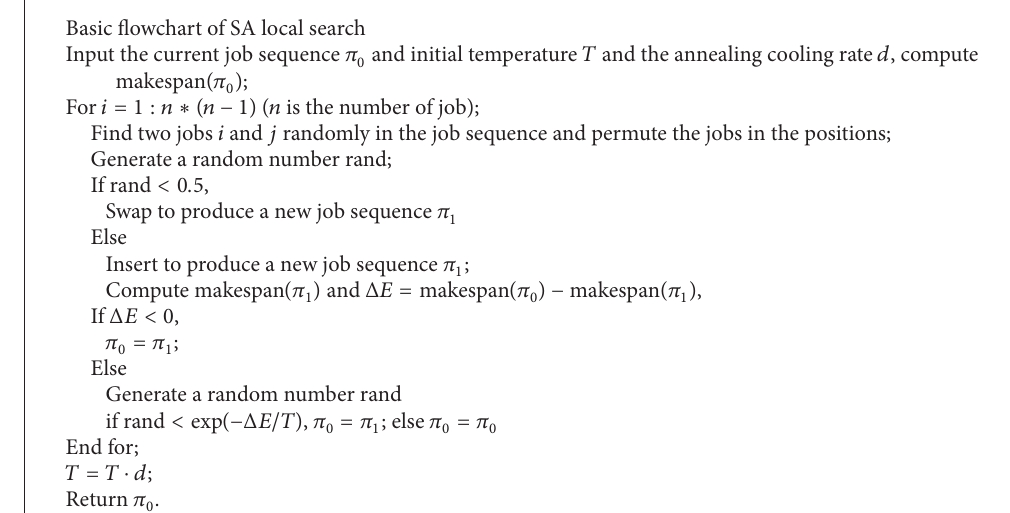
Algorithm 5: The basic flowchart of SA local